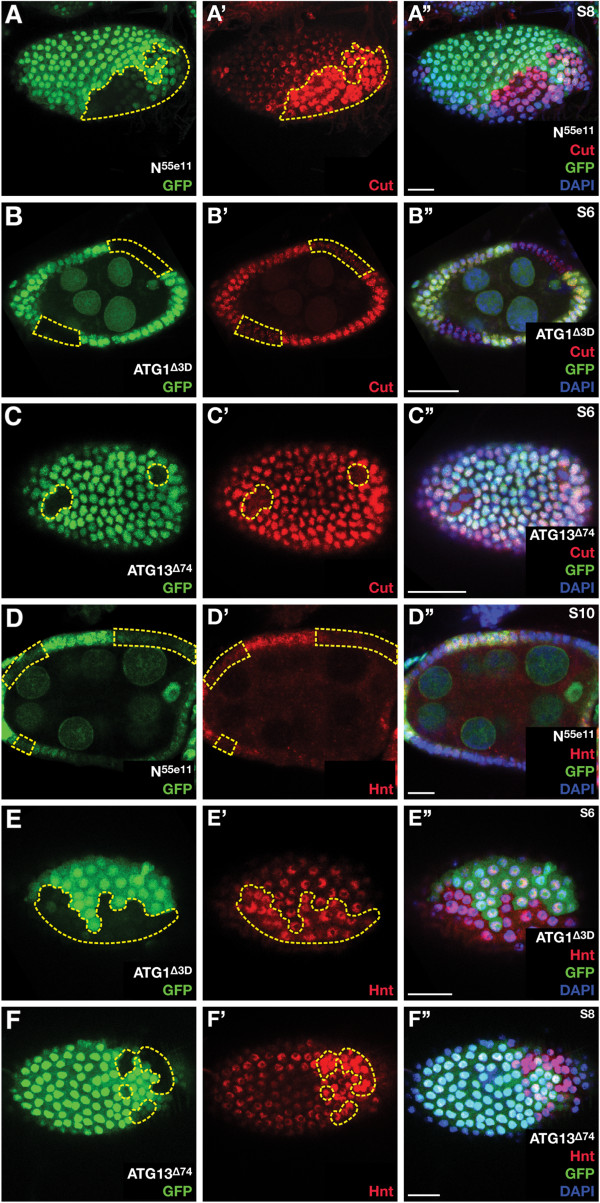
Autophagy modulates Notch signaling in Drosophila FCs. Notch signaling activity in eggs containing ATG mutant FC clones was monitored using the downstream targets Cut and Hindsight (Hnt). (A) In HS-FLP induced FC clones mutant for Notch (marked by the lack of GFP, outlined in yellow), Cut is not downregulated post stage 6. In contrast, ATG1 (B) or ATG13 (C) mutant FCs show a precocious downregulation of Cut compared to WT cells. (D) Under normal conditions, the expression of Hnt is upregulated by Notch signaling, which is not accomplished in cells mutant for Notch (marked by the lack of GFP, outlined in yellow). In FC clones mutant for ATG1 (E) or ATG13 (F), Hnt upregulation occurs earlier or stronger than in surrounding WT cells. Anterior is to the left, posterior to the right. Scale bar: 20 μm. Genotypes: A, D: hs flp FRT19A-UbiGFP/N55e11FRT19A. B, E: hs flp/+; ATG1∆ 3DFRT80B/FRT80B-UbiGFP. C, F: hs flp/+; ATG13∆ 74FRT82/FRT82-UbiGFP
.